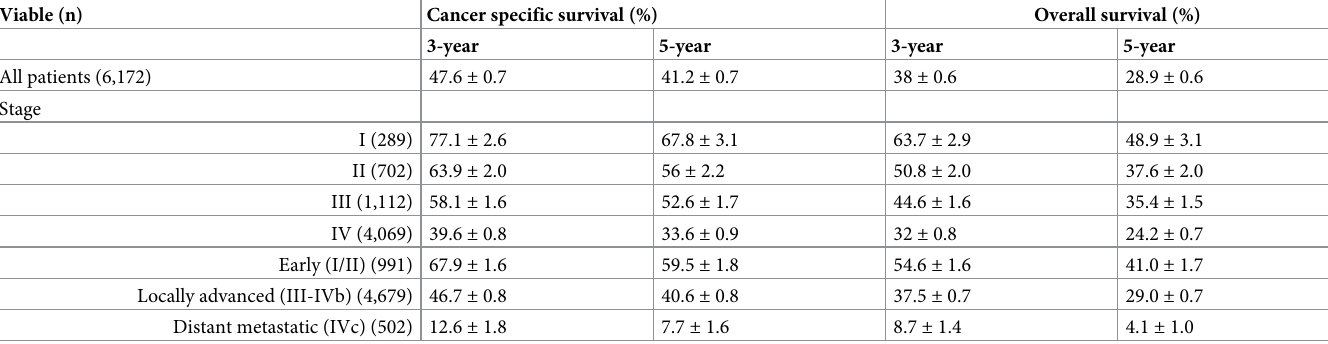
Table 4. Three- and five- year survival rates in patients with hypopharyngeal squamous cell carcinoma diagnosed during 2004–2019. Viable